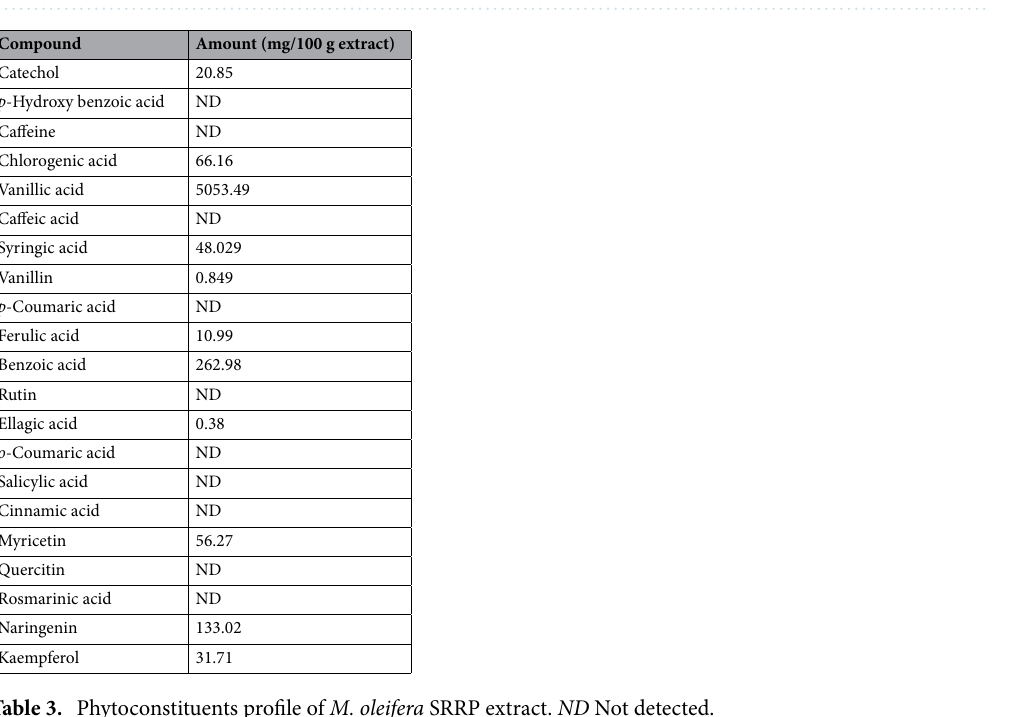
Table 3. Phytoconstituents profile of M. oleifera SRRP extract. ND Not